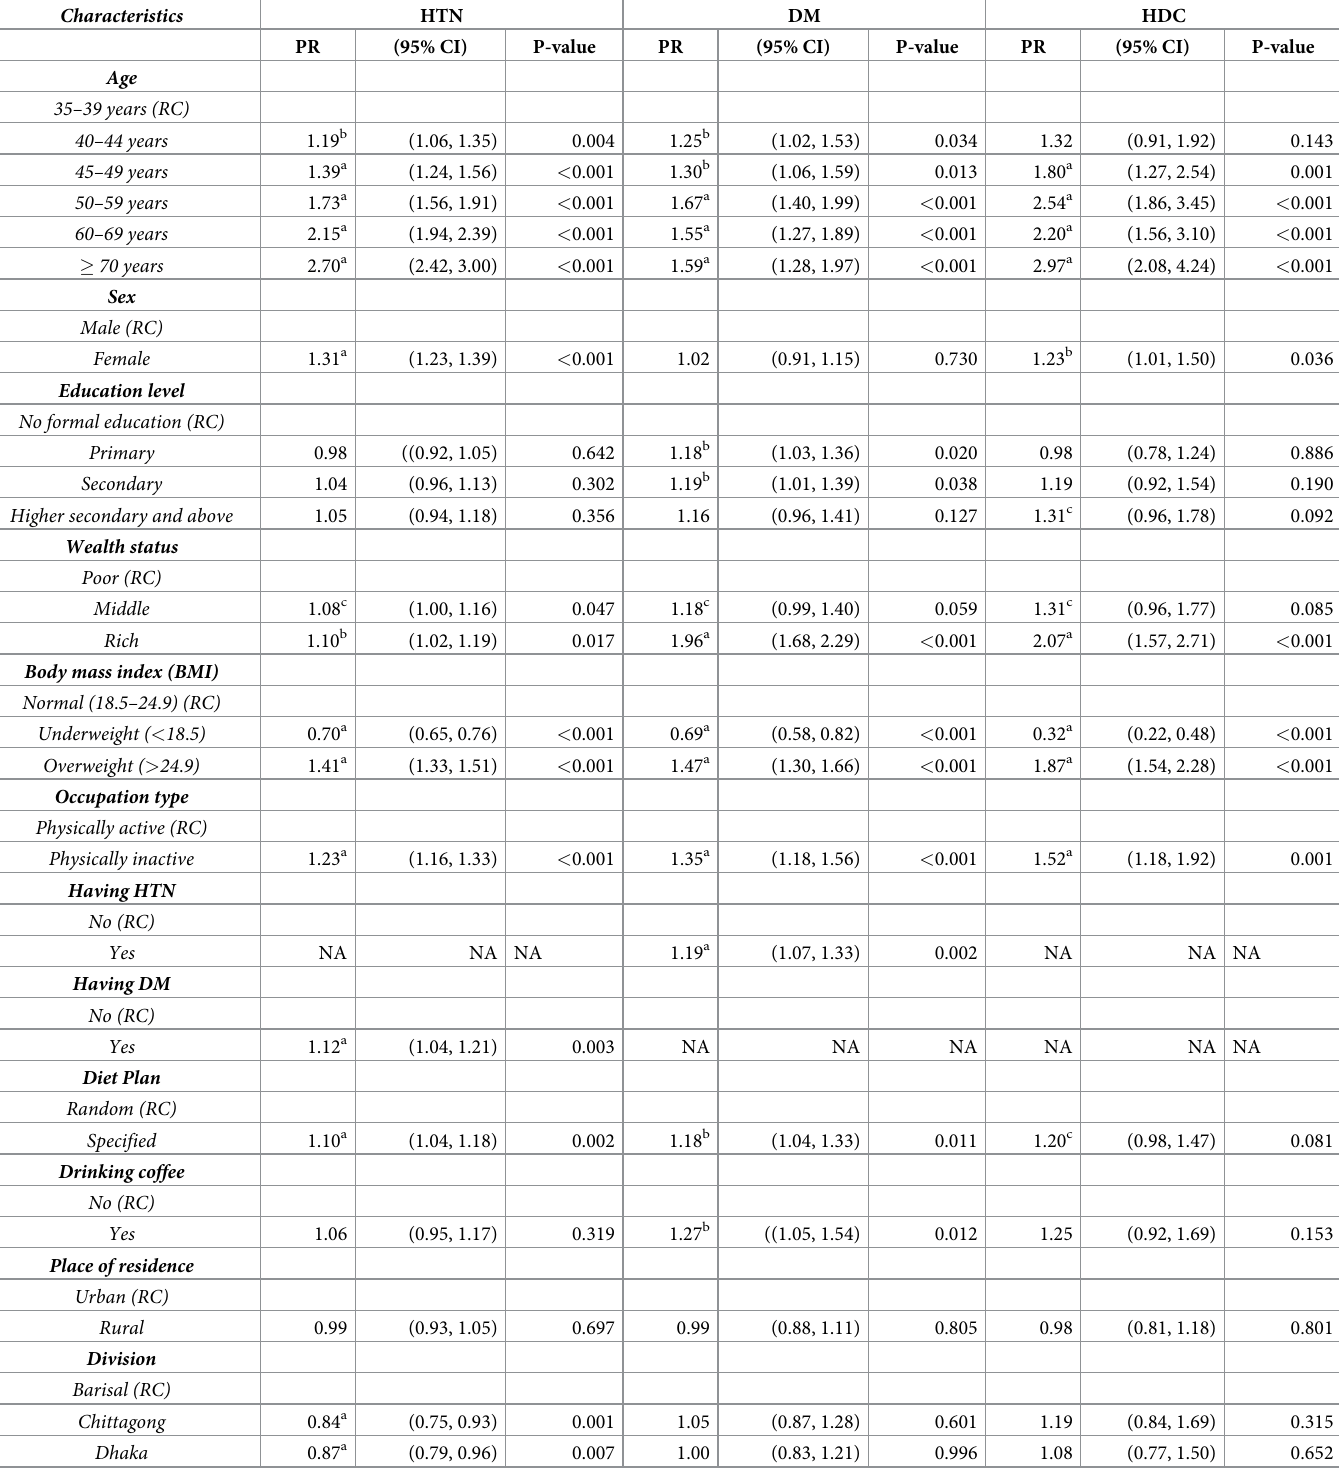
Table 3. Estimated prevalence ratios (PR) with 95% confidence intervals for HTN, DM, and HDC from modified Poisson regression with robust error variance among adults ( � 35 years) in Bangladesh (2011–2018).